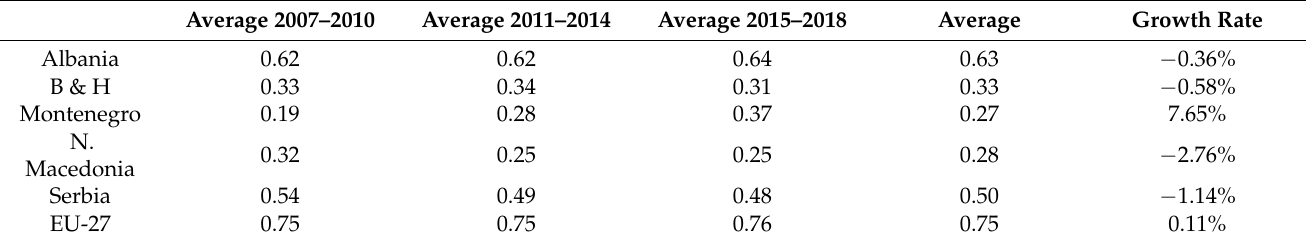
Table 3. Livestock unit per hectare (livestock density) in WB countries and